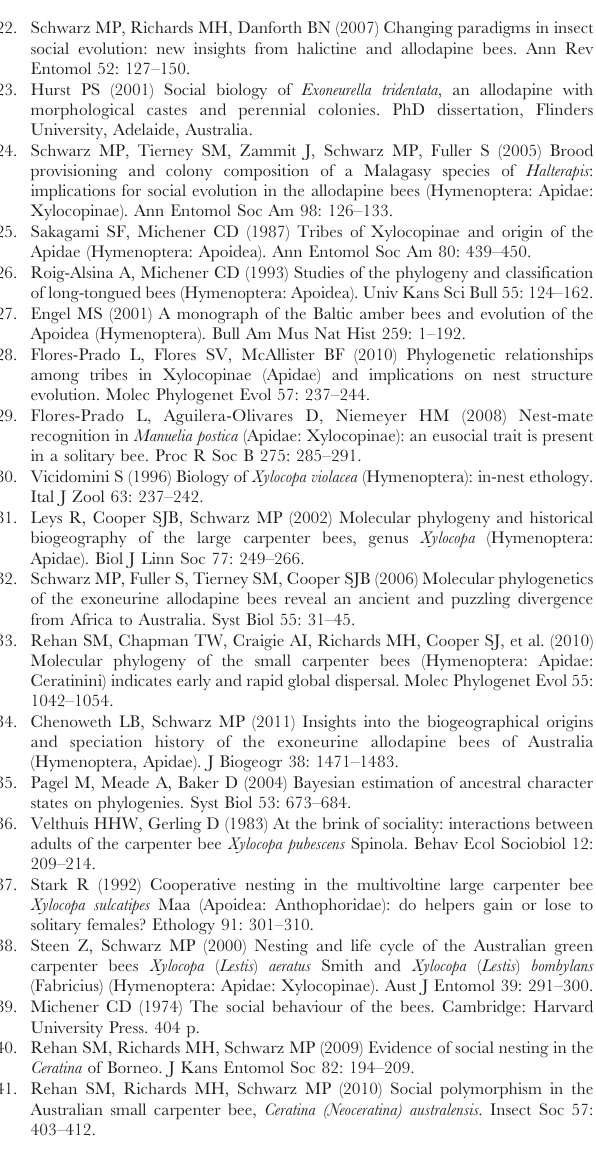
Figure S1 Chronogram obtained from a penalised likelihood transformation of the consensus phylogram obtained from a MrBayes analysis. Figure S2 Consensus phylogeny obtained from the BayesPhylogenies analysis, along with posterior proba- bilities for all nodes.